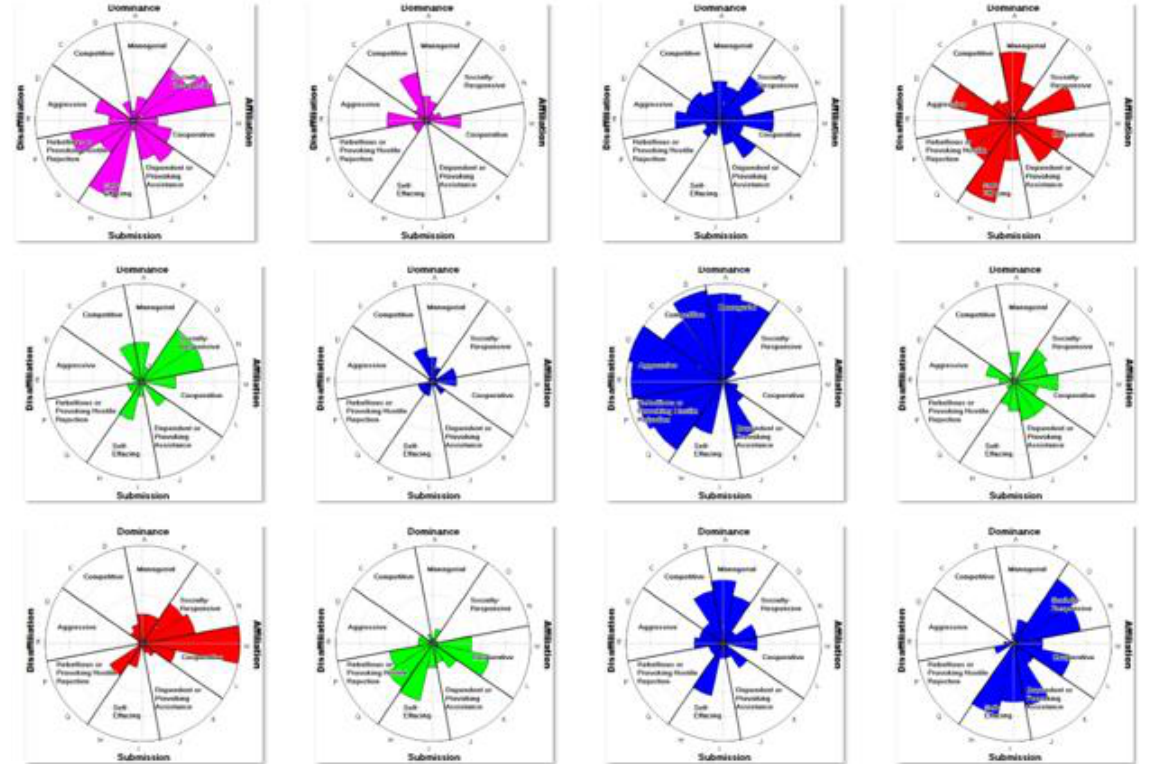
Figure 2: Thumbnail Illustrations of several Client ICL Charts